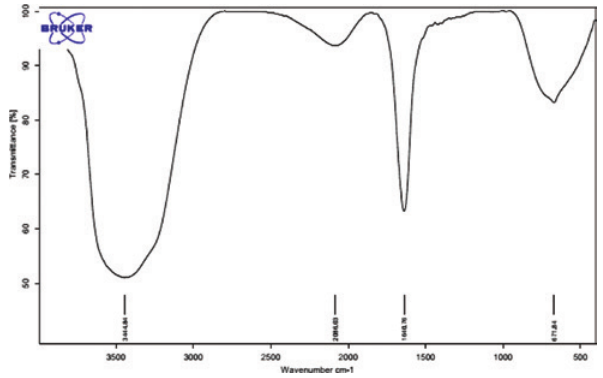
Figure 1: FT-IR spectrum of Aloe vera